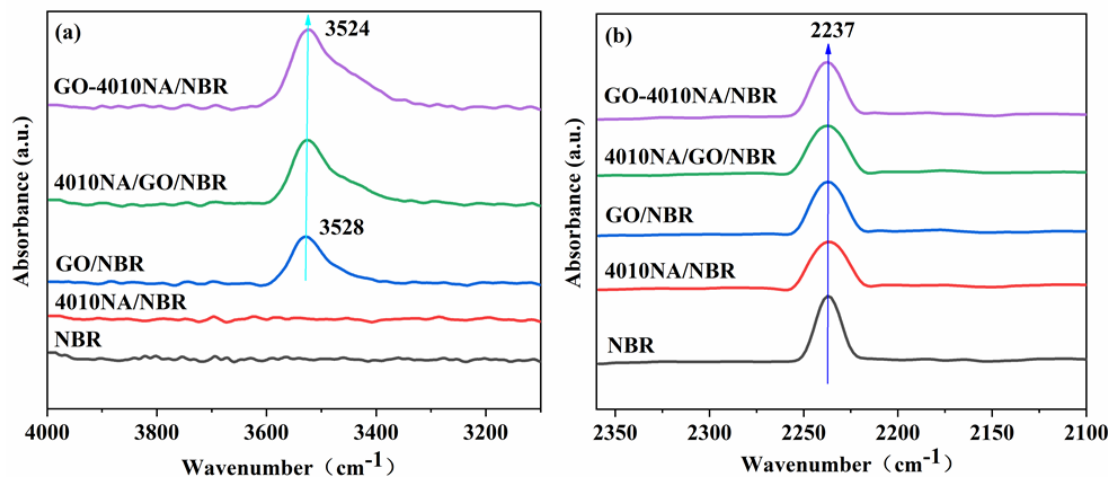
Figure 6. FTIR spectrum of ( a ) NBR composites with different fillers added illustrating the hydroxyl -OH stretching vibration region and ( b ) NBR composites with different fillers added illustrating the nitrile -CN stretching vibration region.